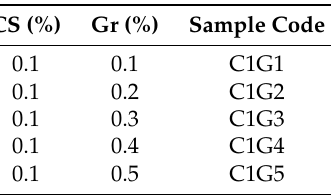
Table 1. Sample codes of di ff erent ratios of chitosan (CS) to graphene